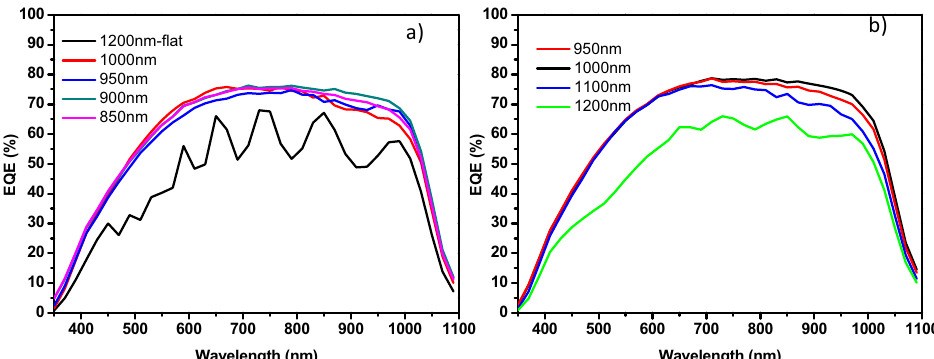
Fig. 5. EQE curves of HJ for different thickness of textured ZnO:Al layer. (a) Cell with flat back side ZnO:Al. (b) Cell with textured back side ZnO:Al.